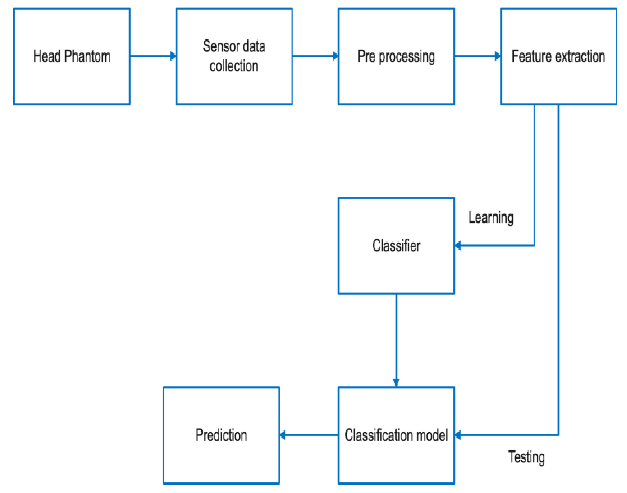
FIGURE 1. Processing steps in detection of Brain tumor